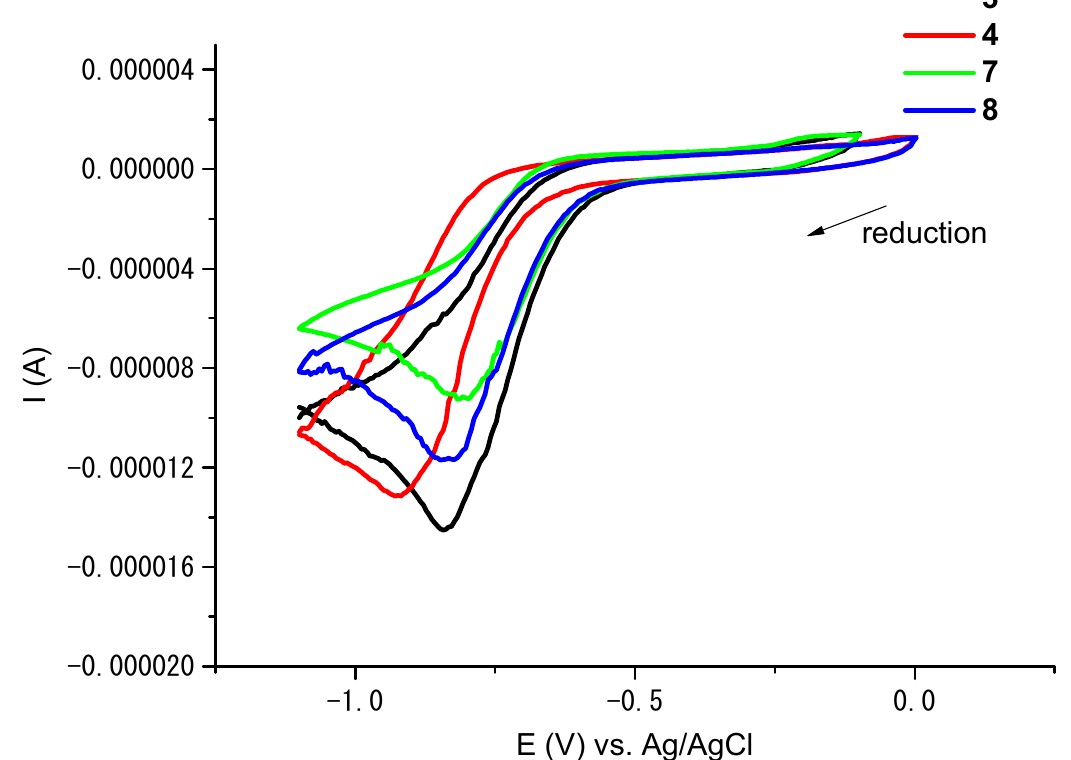
Figure 11. Cyclic voltammograms of nickel complexes, 3 (black), 4 (red), 7 (green) and 8 (blue) in DMSO.